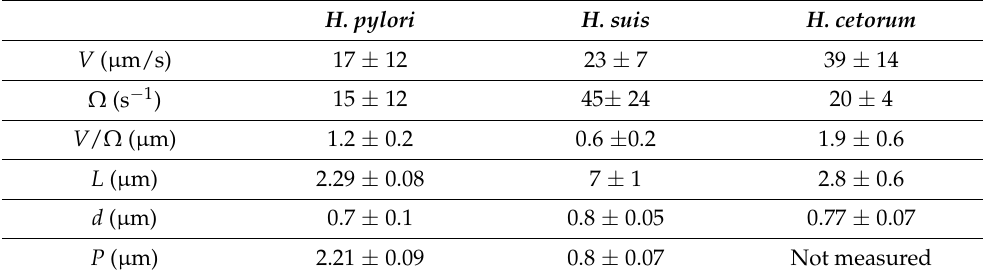
Figure 5. Dot plots of the measured motility and shape parameters for H. pylori in blue (HP), H. suis in green (HS), and H. cetorum in orange (HC) swimming in BB10 broth. The horizontal lines indicate the mean and the vertical lines indicate the standard deviation. ( A ) Average speed, V for each run. ( B ) Body rotation rate, Ω for each run. ( C ) Distance traveled per revolution, V/ Ω , for each run. ( D ) Body length, L of each bacterium. ( E ) Body diameter, d of each bacterium. ( F ) Body pitch, P of each bacterium; H. cetorum is fusiform, it was only slightly helical, and pitch could not be measured from the images obtained in this study. It can be approximated by the body length. The H. pylori data shown here are the same as in [49]. The H. suis data correspond to the EW configuration. Adapted from Constantino [59]. Table 1. Average speed V , cell body rotation rate Ω , and cell shape parameters: length L , diameter d , pitch P of H. pylori , H. suis , and H. cetorum in BB10 broth. The H. suis data are for the EW case, as runs can only be observed in that mode.